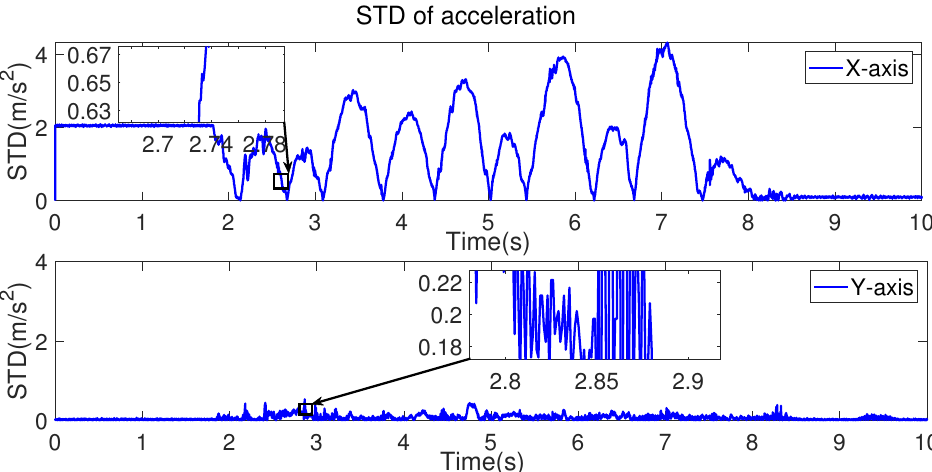
Figure 13. STD of X and Y axes acceleration corresponding to pitch